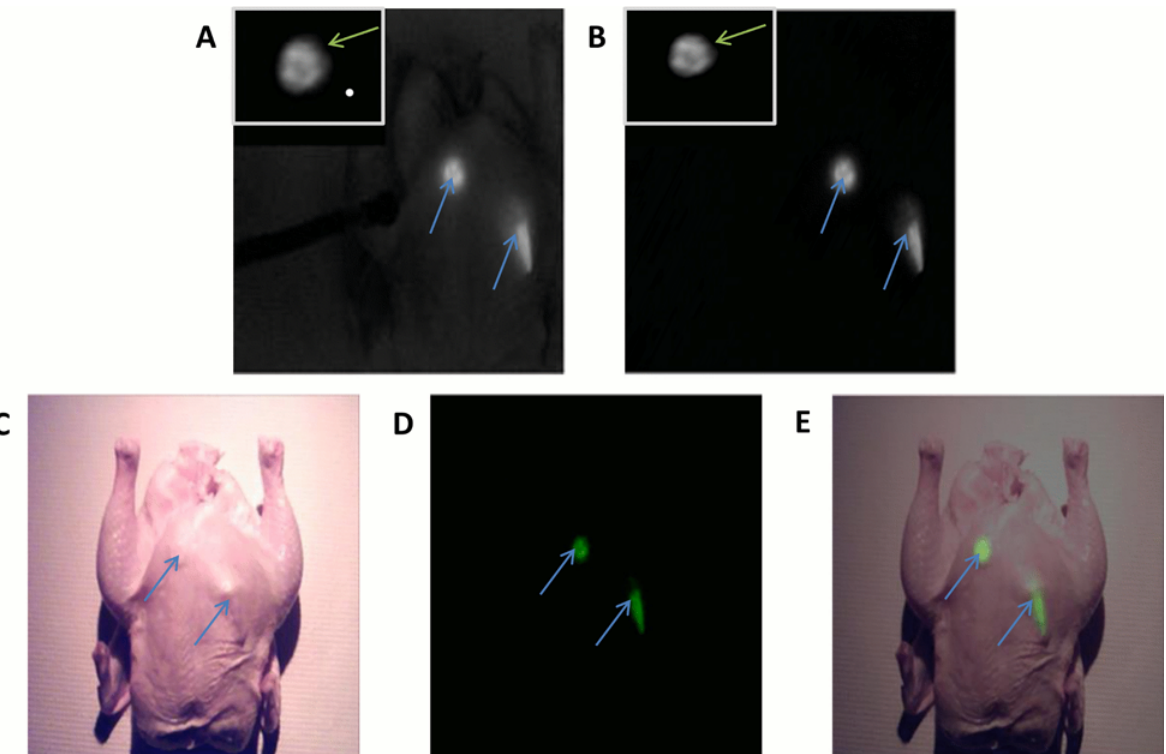
Fig 3. Image-guided surgeries aided by the Integrated Imaging Goggles. Intraoperative imaging using the 2-sensor setup (A) with the addition of unfiltered NIR light for the imaging of anatomical data, and (B) without unfiltered NIR light. Goggle aided stereoscopic imaging of 2 fluorescent targets (blue arrows) under the skin of a chicken. The image from the hand-held microscope is displayed in the top left corner of each frame from the large FOV imaging, displaying a view of the fluorescent targets with higher resolution (green arrows). (C) Intraoperative imaging using the 4-sensor setup: The anatomical information from the color reflectance imaging; (D) the functional information from fluorescence imaging. The detected fluorescence was pseudocolored in green to facilitate visualization; (E) the composite fluorescence and color reflectance images displayed to the user.